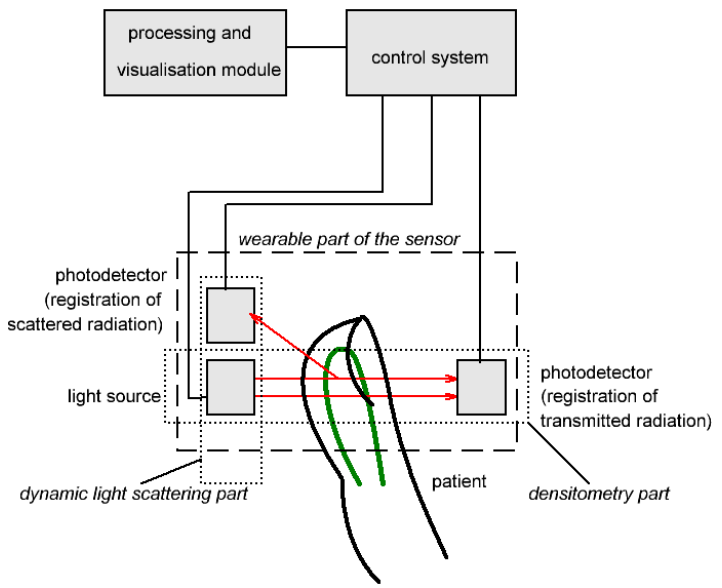
Figure 1. Design of the combined densitometry–dynamic light-scattering setup for liver function assessment. Arrows show transmi tt ed and sca tt ered light.